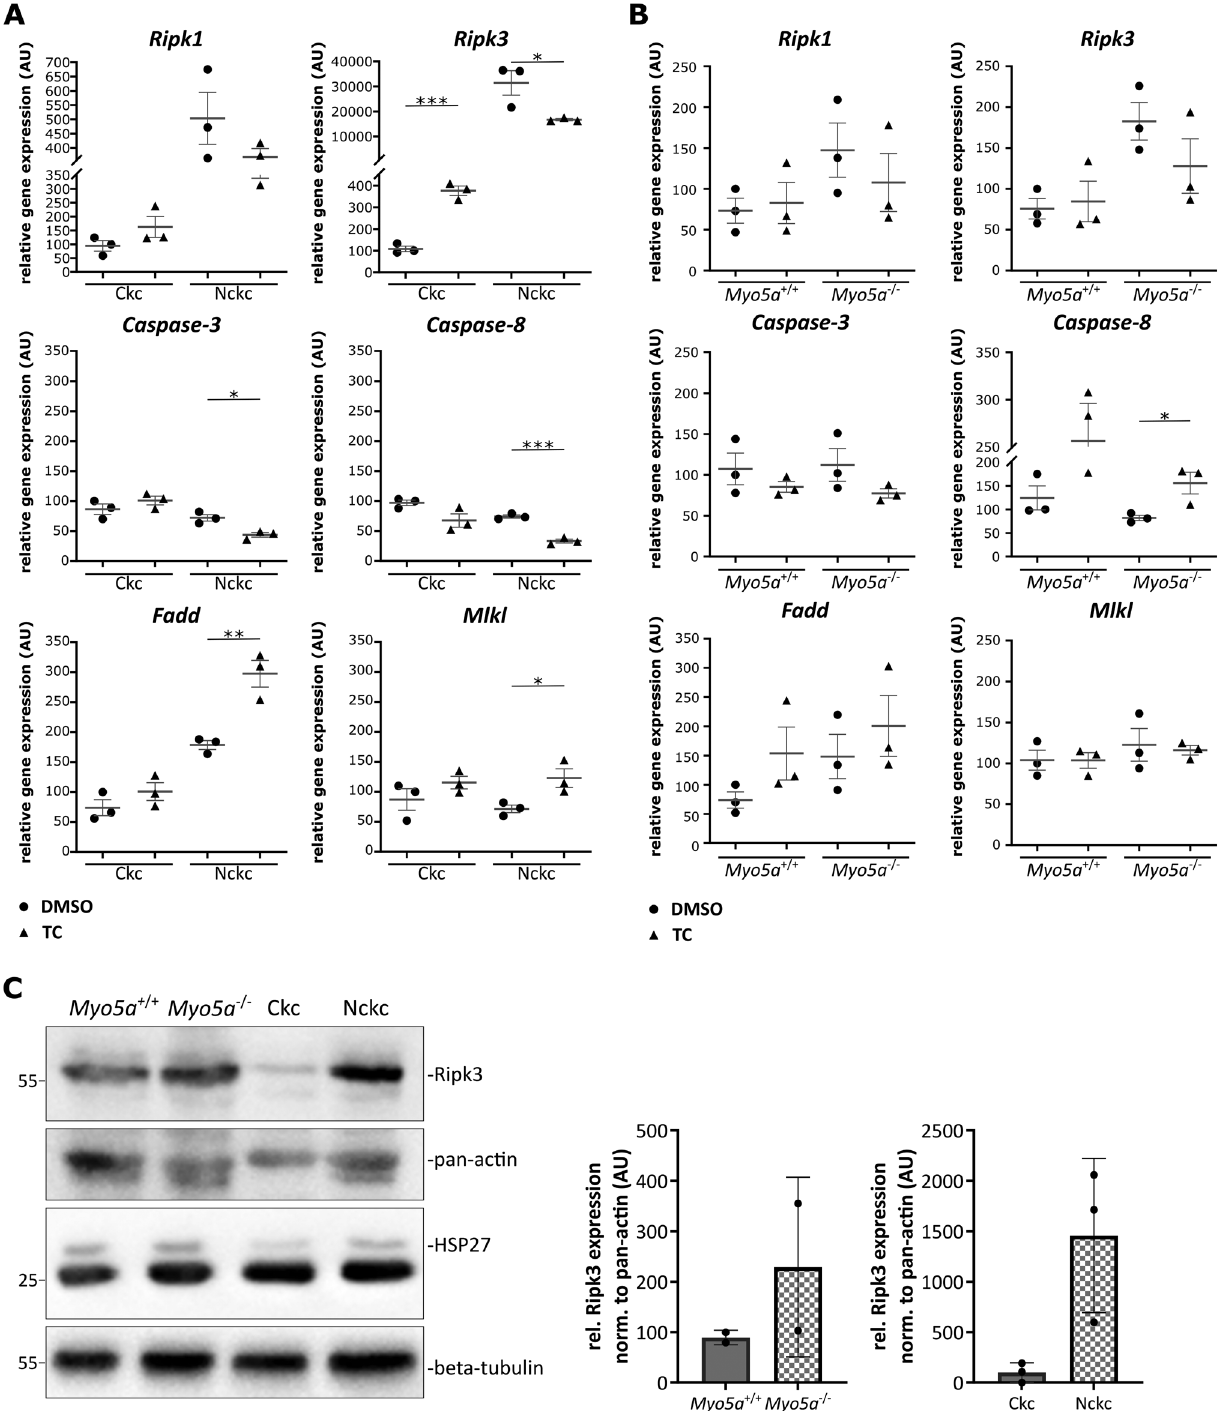
Fig. 3 Increased expression of Ripk3 in cells lacking primary cilia. A , B Quantitative real-time PCR of several cell death-related genes in mIMCD3 cells revealed upregulation of necroptosis players in non-ciliated cells: A Ckc versus Nckc ( n = 3); B control versus Myo5a − / − ( n = 3). Cells were treated with TNF α (TNF, 4 ng/100 µl) and cycloheximide (CHX, 2 µg/100 µl) for 16 h or with DMSO. Statistical analysis was performed by using a one-way ANOVA followed by a two-sided Student ’ s t test ( p value: >0.001***; 0.002**; 0.033*; ns = 0.12). C Immunoblot analysis of lysates from untreated ciliated ( Myo5 + / + /Ckc) and non-ciliated ( Myo5a − / − /Nckc) cells using Ripk3 (~57 kDa) and HSP27 (~27 kDa) antibodies. Pan-actin (~30 kDa) or beta-tubulin (~55 kDa) were used as controls. mRNA in non-ciliated cells and a trend toward increased comparing Ckc with Nckc (Fig. 3A) as well as Myo5a + / + with expression for Ripk1 and Fadd. Immunoblotting con fi rmed Myo5a − / − cells (Fig. 3B). While caspase-3 and caspase-8 expres- increased levels of Ripk3 on the protein level in both cell lines sion levels were independent of the presence of primary cilia, without cilia (Fig. 3C). Susceptibility to TNF α could result from these data revealed signi fi cantly higher expression levels of Ripk3 Cell Death Discovery (2022)